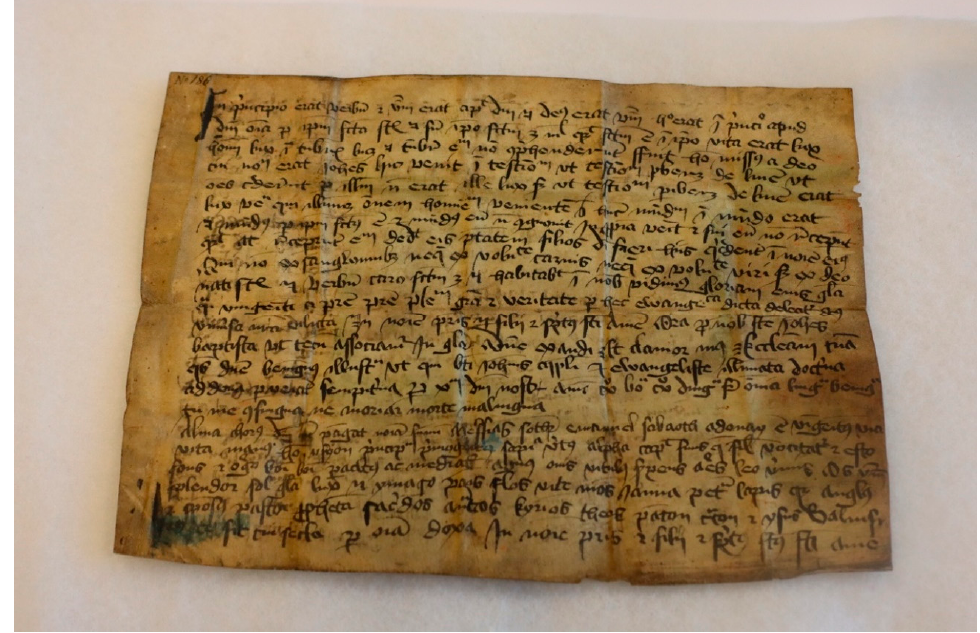
Figure 6. Amulet from Aust Agder, Latin text. Ink on parchment, 1400–1450. Photo: Kaja M. H. Hagen.